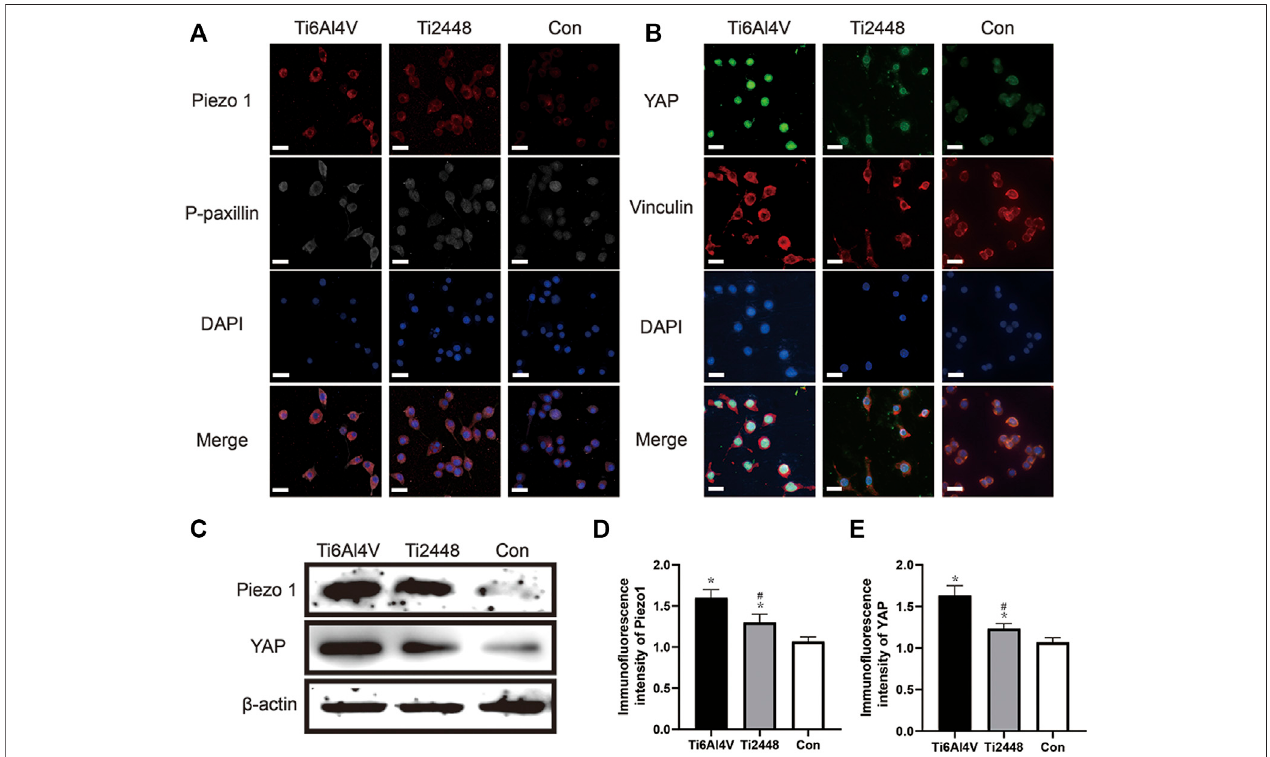
FIGURE 12 | Substrate stiffness regulates Piezo1 expression and YAP nuclear translocation. Piezo1 expression and cell adhesion to the extracellular matrix (focal adhesion) were observed by immuno fl uorescence. Scale bar (cid:2) 20 µm (A) . Effect of different substrate stiffnesses on YAP localization in macrophages evaluated by immuno fl uorescence staining. Scale bar (cid:2) 20 µm (B) . Piezo1 and YAP expression in different groups (C) . Quantitative analysis of immuno fl uorescence intensity (D,E) . Note: * p ＜ 0.05 compared to the control; # p ＜ 0.05 compared to Ti2448.